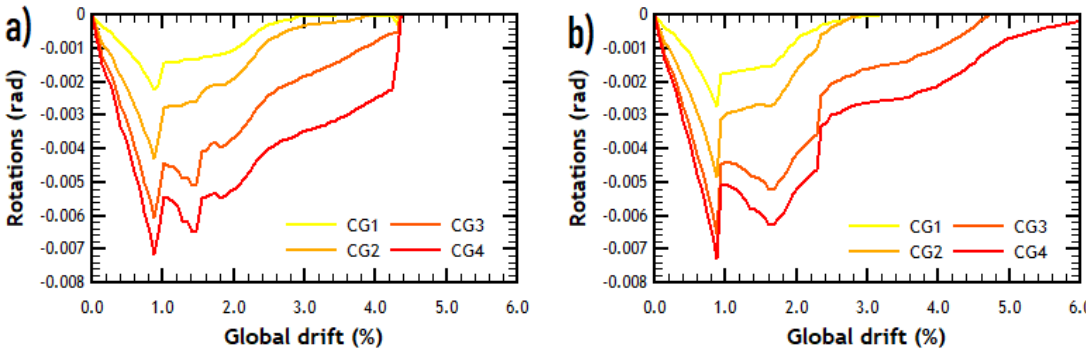
Figure 10. Variation in the rotations of the centers of gravity of each floor with respect to the lateral displacement according to different pushover analyses: ( a ) conventional pushover analysis and ( b ) adaptive pushover analysis.